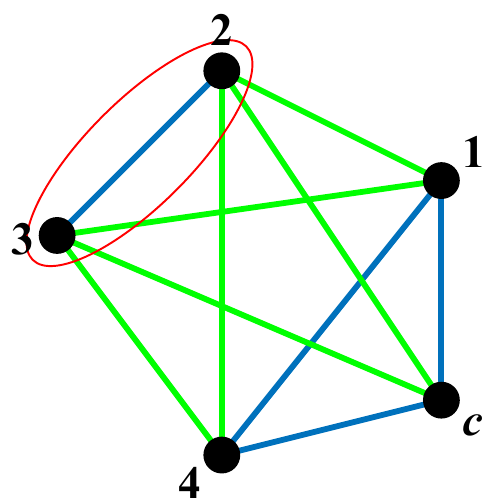
Figure 6 . A simplified network diagram corresponding to the figure 5(b). Each elementary region is simplified by a point and the component flow flux is represented by the line segment connecting two points. Then for example, the entropy of the region in red circle is equal to the sum of the green lines in this